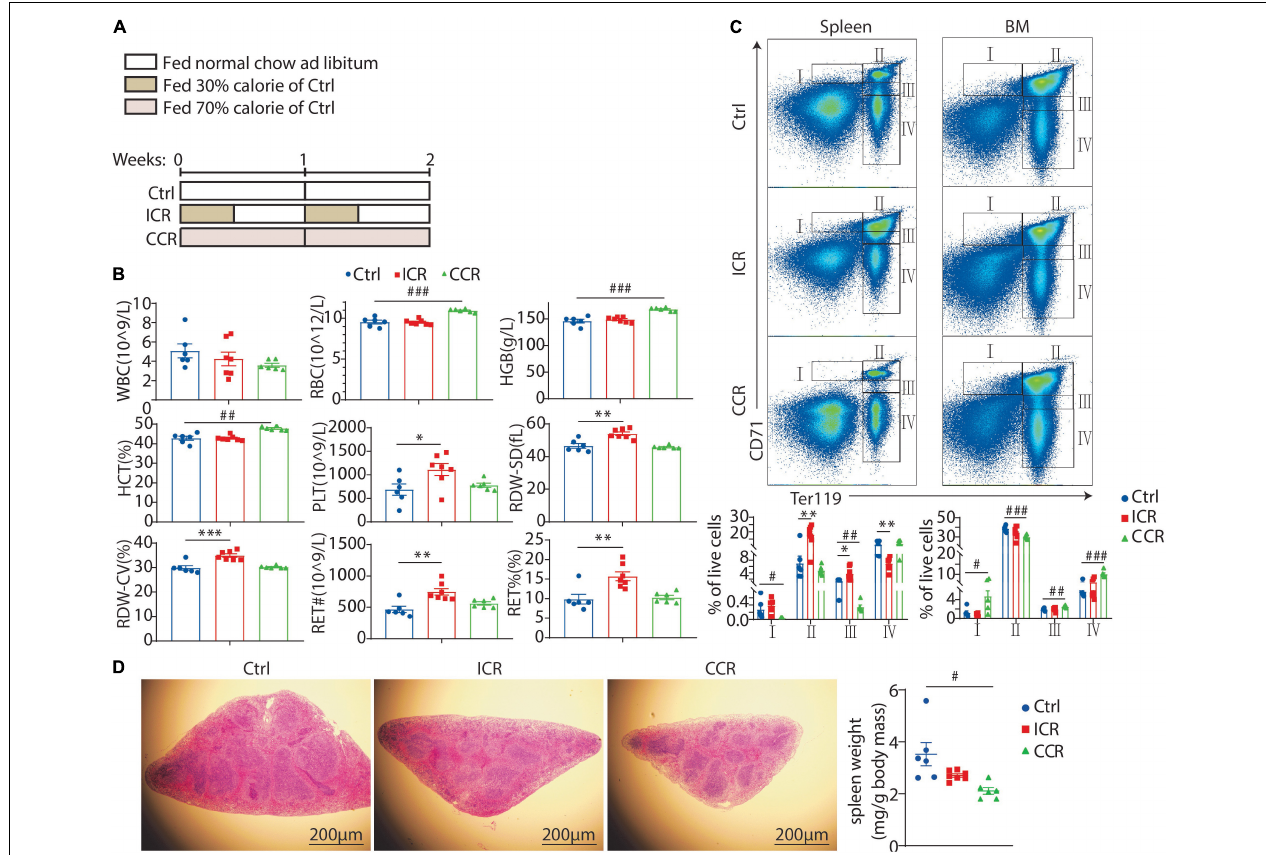
FIGURE 2 | Effect of a short-term CR on erythrocyte development in mice. (A) A schematic diagram showing the design of the experiment. Seven-week-old male C57BL/6 mice were divided into three groups ( n = 6 for each group). (B) Blood count of the mice using peripheral blood, including white blood cell (WBC), red blood cell (RBC), hemoglobin (HGB), hematocrit (HCT), platelet count (PLT), red blood cell volume distribution width standard deviation (RDW-SD), red blood cell volume distribution width coefficient of variation (RDW-CV), and reticulocyte (RET). (C) The proportion of erythroid cells at different stages in the spleen and bone marrow, including stage I (CD71 hi Ter119 int , proerythroblast), stage II (CD71 hi Ter119 hi , basophilic erythroblast), stage III (CD71 int Ter119 hi , mixture of polychromatophilic erythroblast and orthochromatic erythroblast and reticulocyte), and stage IV (CD71 − Ter119 hi , mature RBCs). (D) Representative images of H&E staining of the spleen with its weight shown in the right panel. Scale bars: 200 µ m. All the data are presented as mean ± S.E.M. ∗ P < 0.05, ∗∗ P < 0.01, ∗∗∗ P < 0.001 for difference between control and intermittent CR groups. # P < 0.05, ## P < 0.01, ### P < 0.001 for difference between control and continuous CR groups.